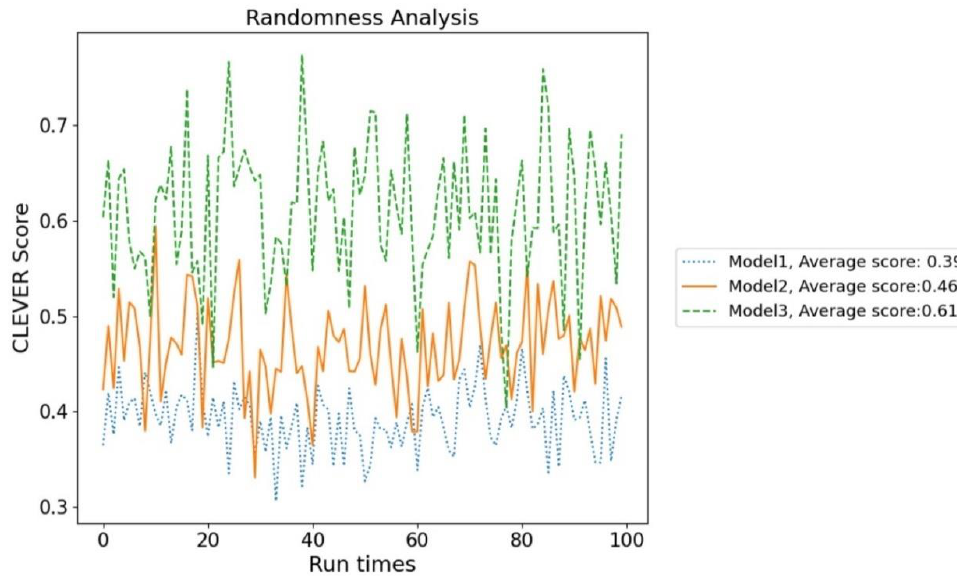
Figure 6. CLEVER score randomness analysis.